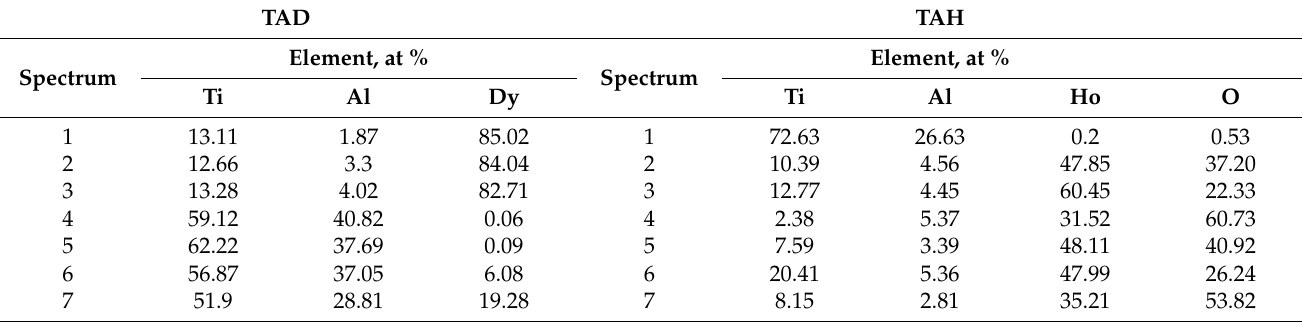
Table 3. Summary table of the EDS results.